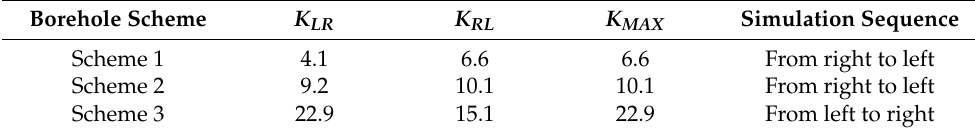
Table 4. The estimated values of K for various borehole schemes.